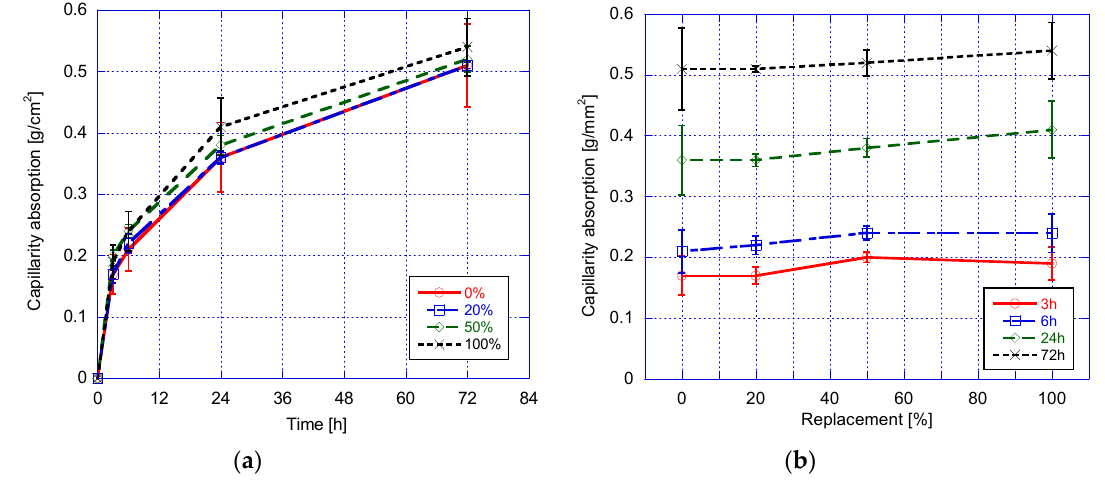
Figure 3. Capillarity absorption vs. time ( a ) and capillarity absorption vs. replacement ratio ( b ).